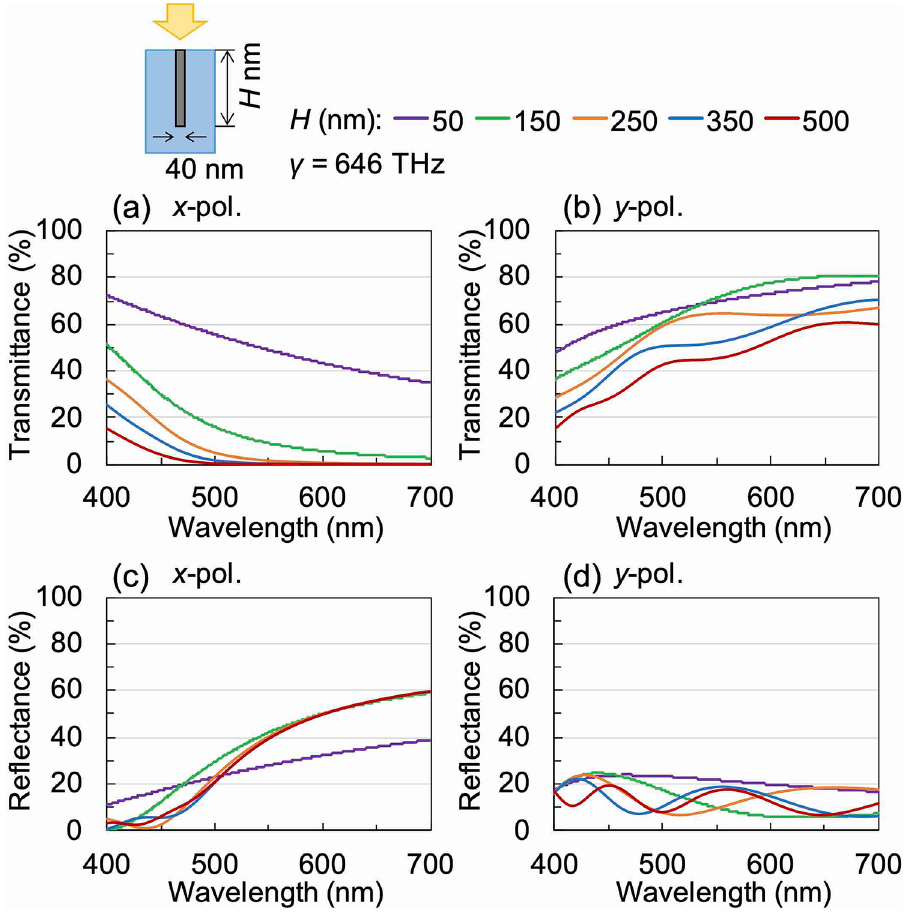
Figure 4. Calculated ( a ), * b ) transmittance and c , d reflectance spectra of embedded WGP sheet as a function of the thickness of the wire grid structure H . The polarisation directions are * a ), ( c ) x -polarisation and ( b ), ( d ) y